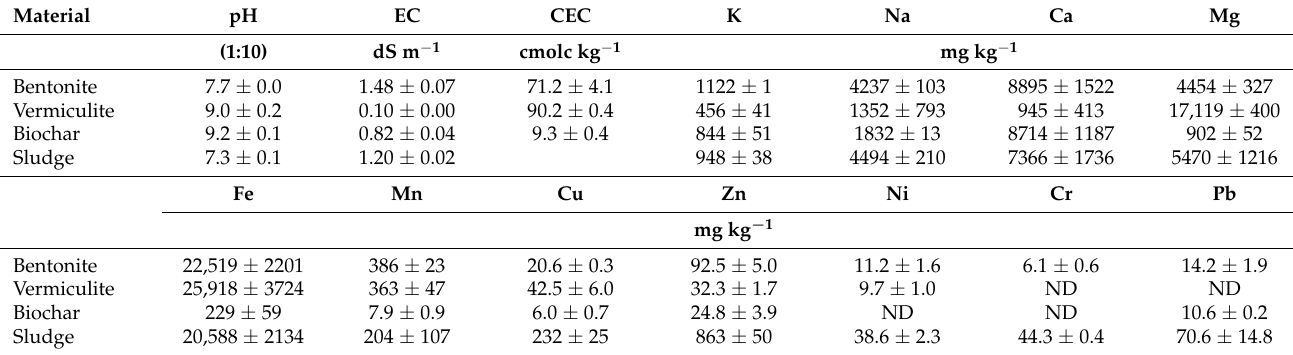
Table 1. Certain chemical properties and total composition (expressed on dry weight basis) of sewage sludge and the materials used for its stabilization. CEC: cation exchange capacity; EC: electrical conductivity; SAR: sodium adsorption ratio; ND: not